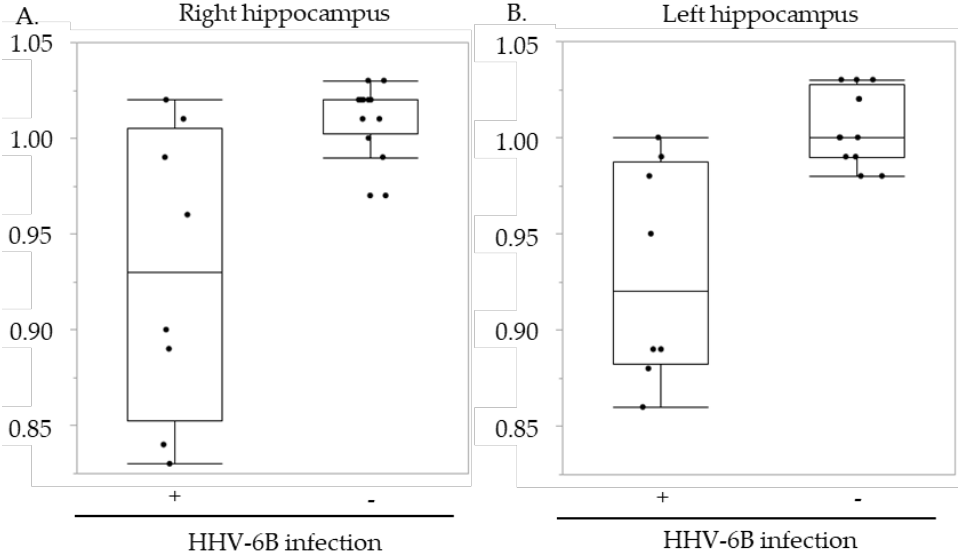
Figure 3. The hippocampal volume ratio before and after transplantation. ( A ) Right hippocampus; ( B ) Left hippocampus. The vertical axes indicate the hippocampal ratio of the hippocampal volume from before to after hematopoietic stem cell transplantation recipients with (+) and without ( − ) human herpesvirus 6B (HHV-6B) infection.